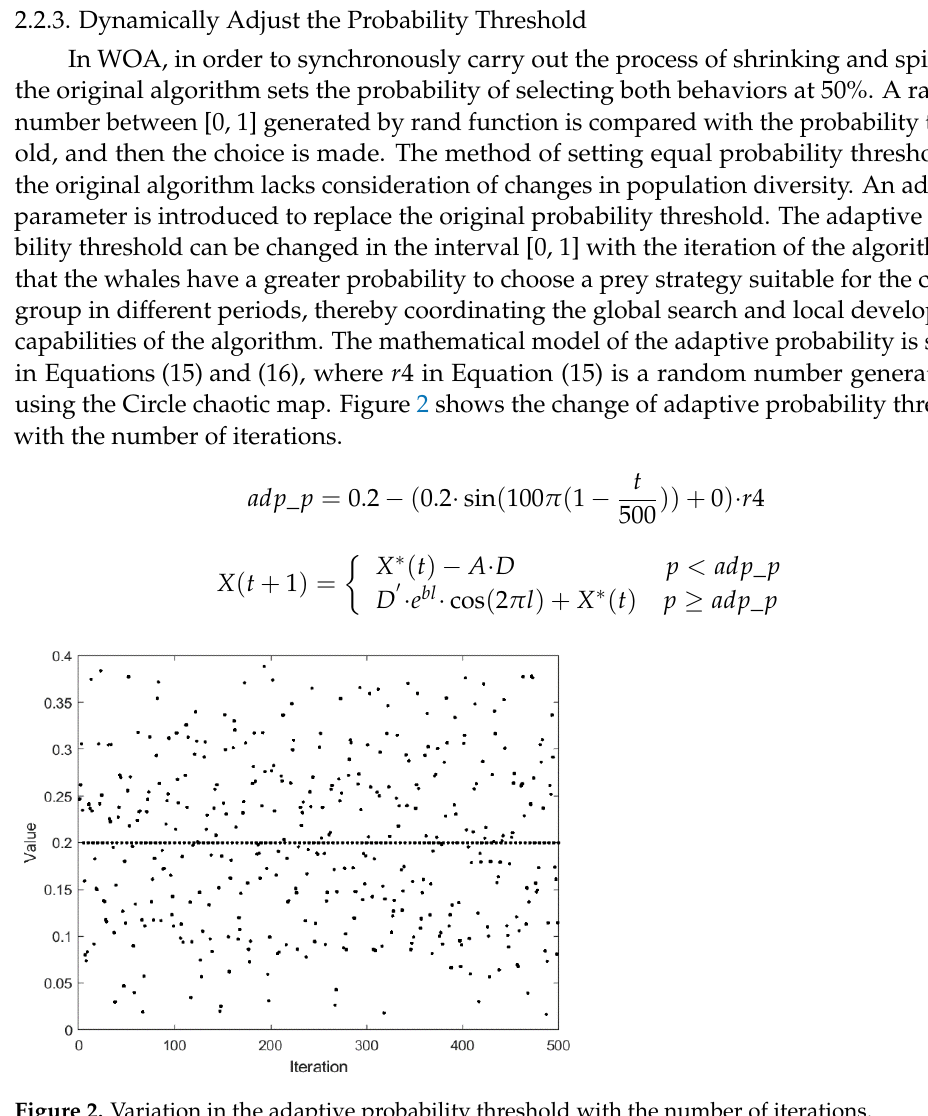
Figure 2. Variation in the adaptive probability threshold with the number of iterations.